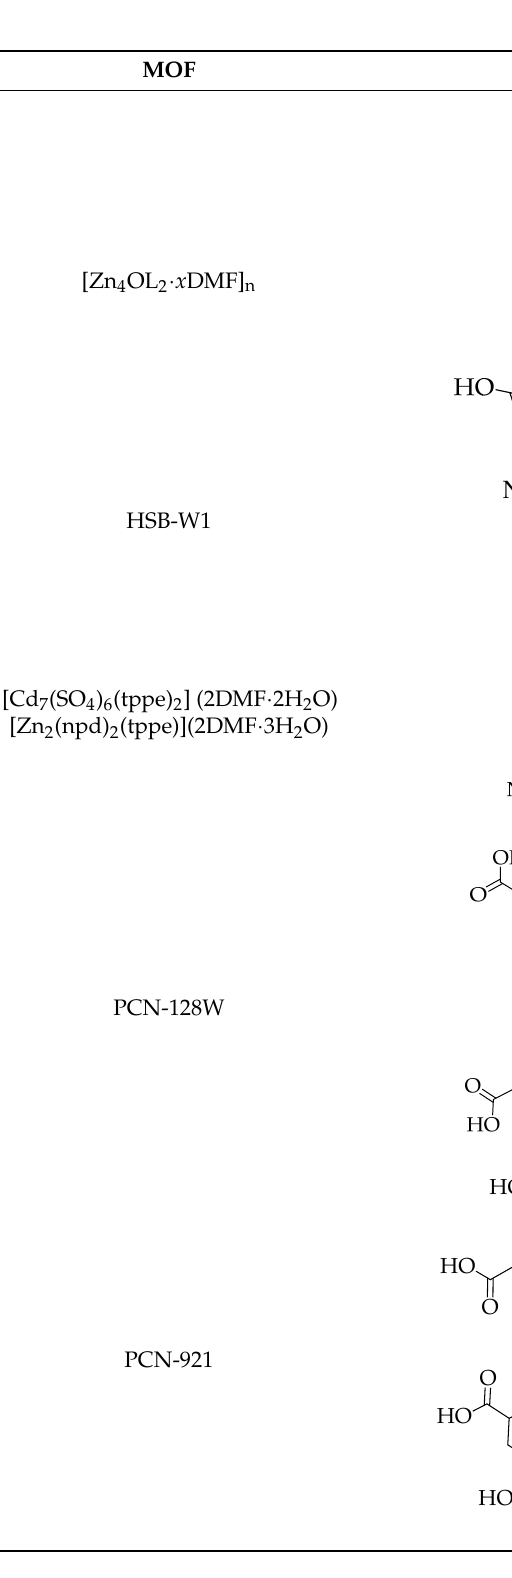
Table 2. Key parameters for white LEDs with dye-encapsulated MOFs as phosphors. Dye-Encapsulated MOF Materials